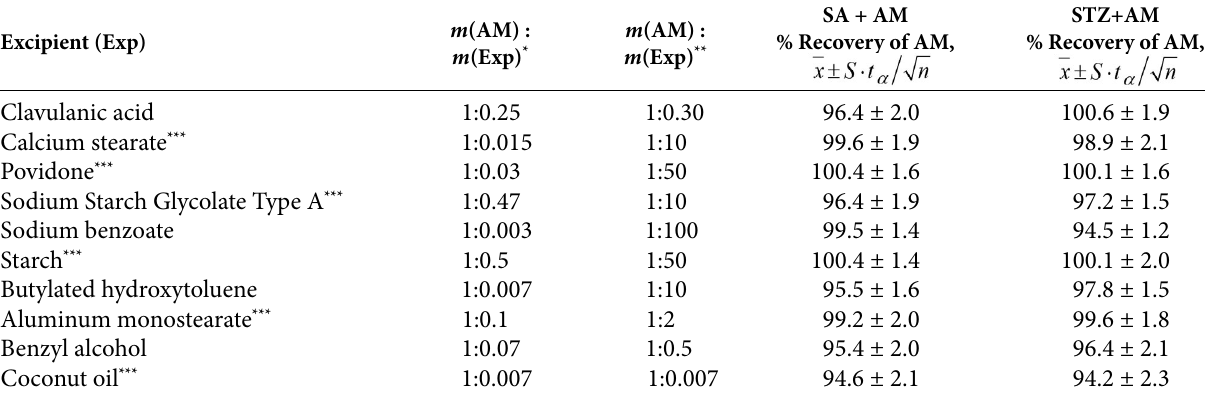
Table 5. Effect of excipients on the AM assays by SA and STR. С НСІ = 0.6 М, С SA = 4.5 ∙ 10 –4 М, C NaNO М, C